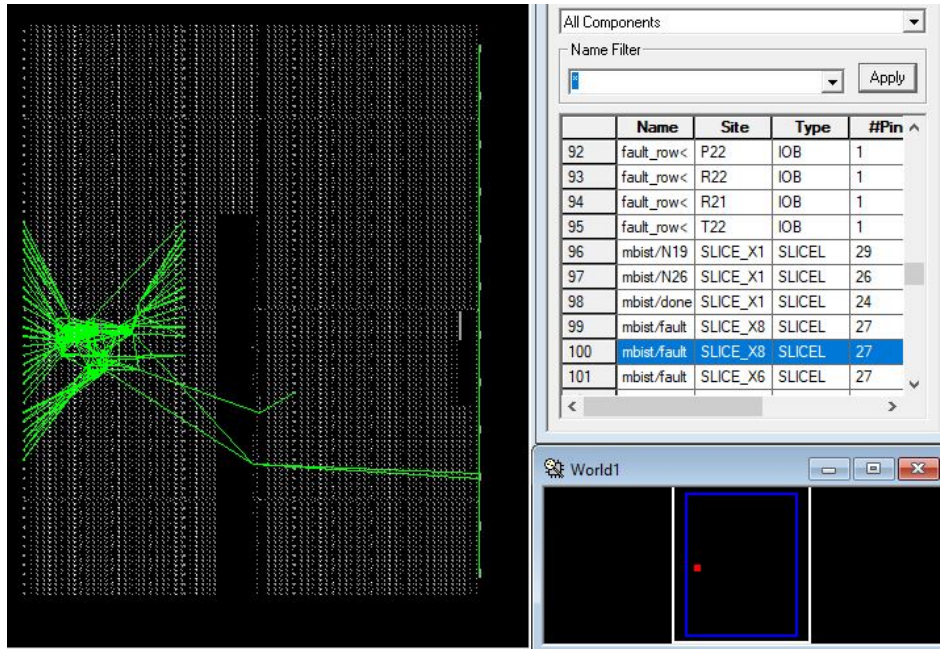
Figure 8. Package layout view. Table 4. Design Specifications on FPGA.